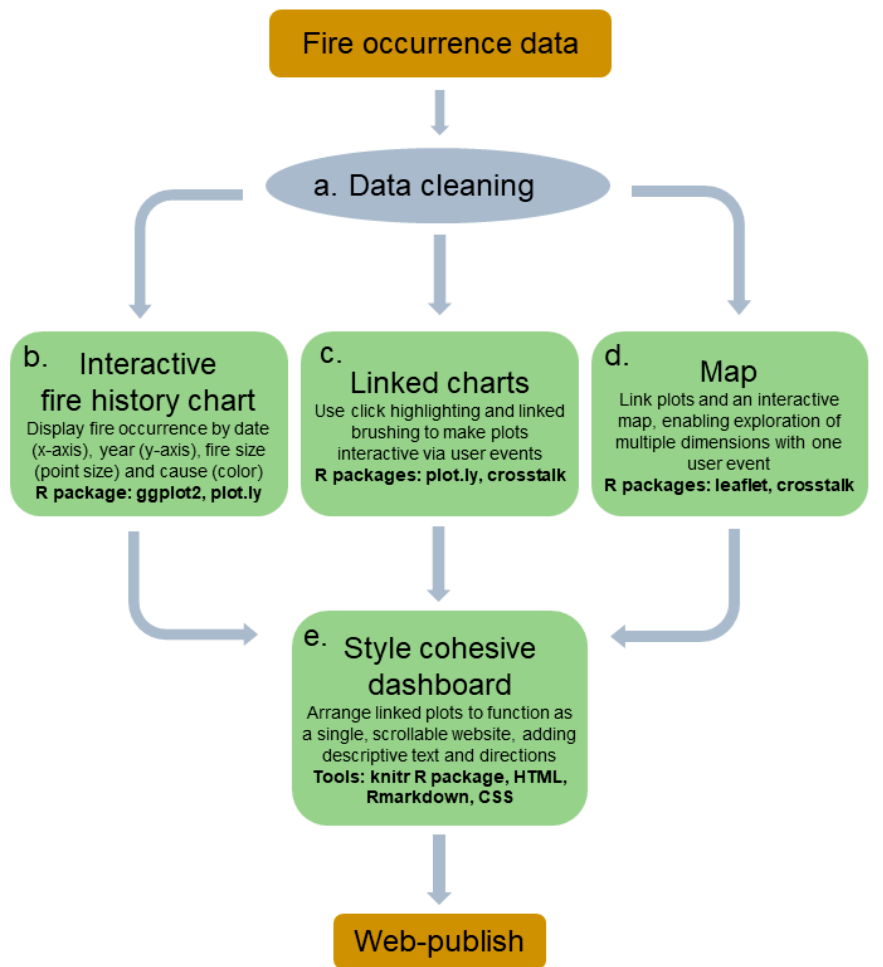
Figure 1. The workflow, packages, and libraries used in creation of the visualization dashboard, from tabular data to the final website. The code for this process is available on github.com/ncsu-land- change-lab/vistafire (see supplementary material).